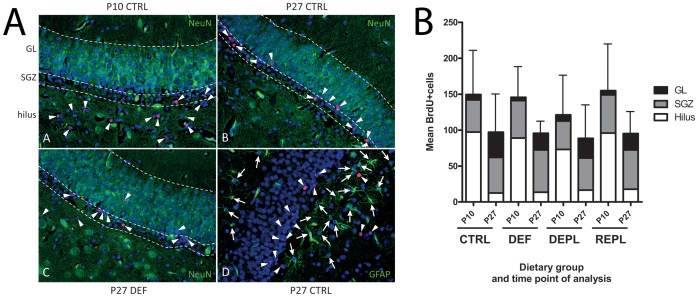
Evaluation of proliferation, survival and migration of precursor cells in the dentate gyrus. A:Representative dentate gyrus area of immunofluorescence-labeled sections used for assessing the location and phenotype of cells born between P5 and P9. Sections of animals sacrificed at either P10 or P27 were analyzed for BrdU-positive cells (red; arrowheads) together with the mature neuronal marker NeuN (Panels A to C) or the astrocyte marker GFAP (D; arrows) (both in green). DAPI (blue) was used to stain cell nuclei. Hatched lines denominate the border zones between hilus, SGZ and GL. B: Graphical data from evaluation of immunofluorescence images, example shown in Figure 2b. Results are presented as the mean number of BrdU-positive cells in the different areas of the dentate gyrus for 4–5 regions per animal ± SD for total cell number. N = 7–10 animals per treatment group. We found no difference in the total number of BrdU-positive cells between the different treatment groups analyzed at either P10 or P27 by One-way ANOVA.